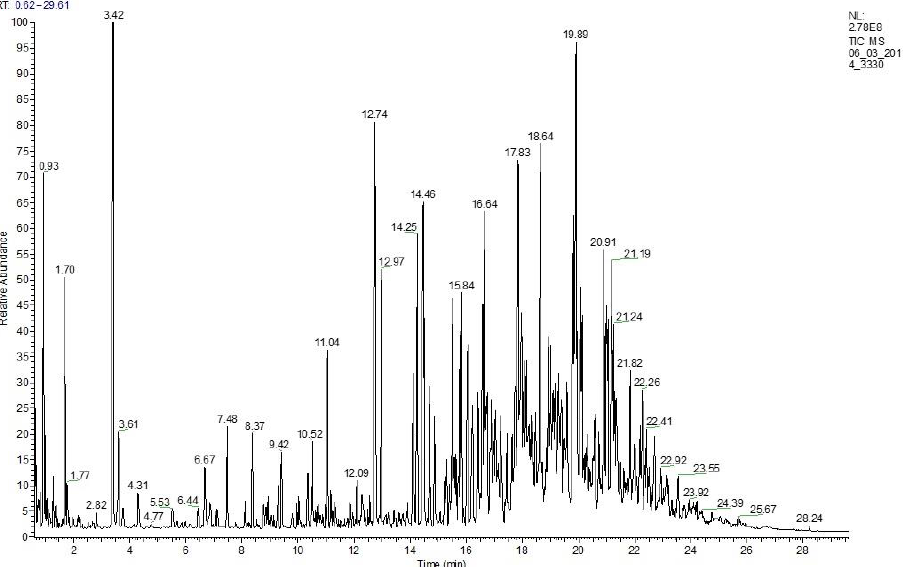
Figure 2. The GC – MS spectrum of the liquid product of the PS depolymerization in LCO medium over the Y zeolite at 550 °C, WHSV 85 h −1 , and PS concentration 10%. Table 5. The GC-MS spectrum component composition of the liquid product of the PS depolymerization in LCO medium over the Y zeolite at 550 ◦ C, WHSV 85 h − 1 , and PS concentration 10%.